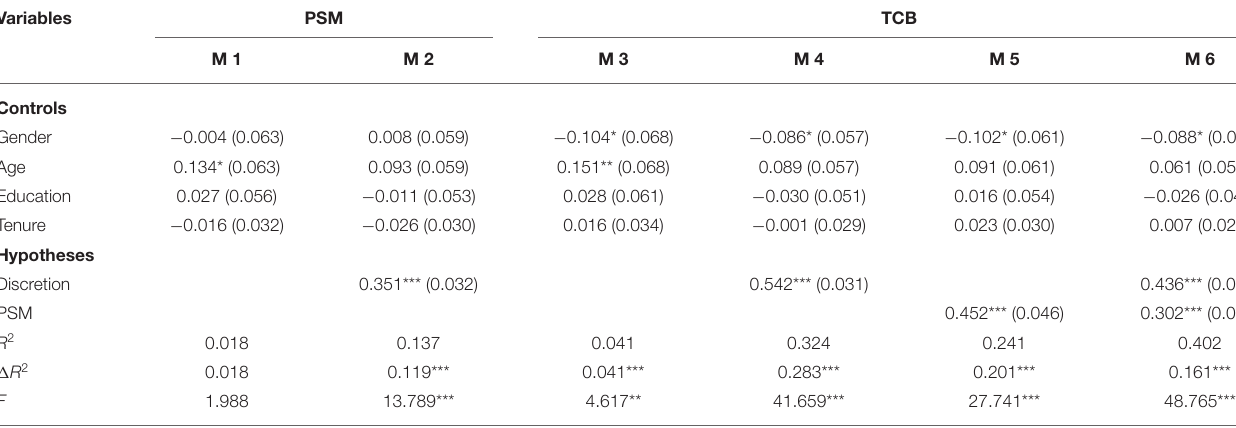
TABLE 6 | Results of multiple regression analysis (robust standard errors in parentheses).